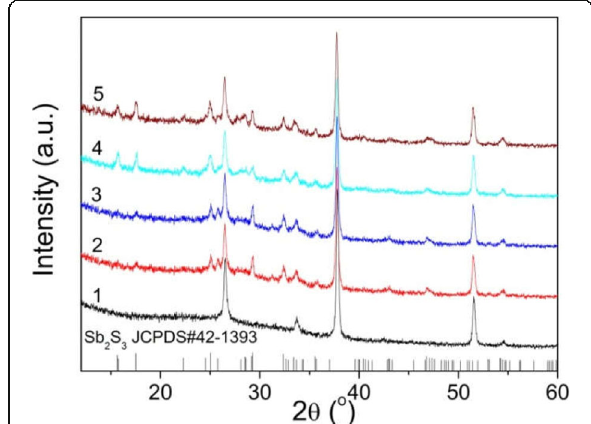
Fig. 3 XRD patterns of the as-synthesized Sb 2 S 3 film on FTO with different deposition time. Sample 1 is the pure FTO glass substrate, and samples 2 – 5 are Sb 2 S 3 films with t of 1 h, 1.5 h, 2 h, and 3 h, respectively